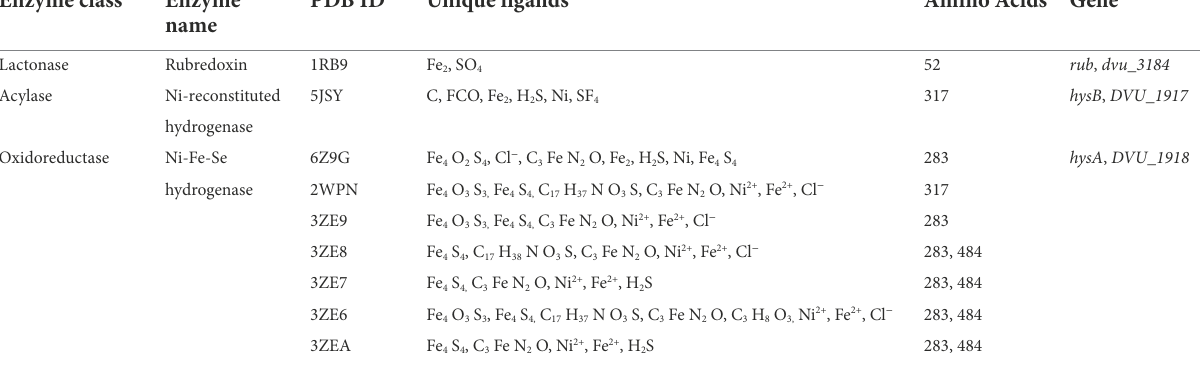
TABLE 2 Classification and molecular characterization of the quorum quenching enzymes * . Enzyme class Enzyme PDB ID Unique name